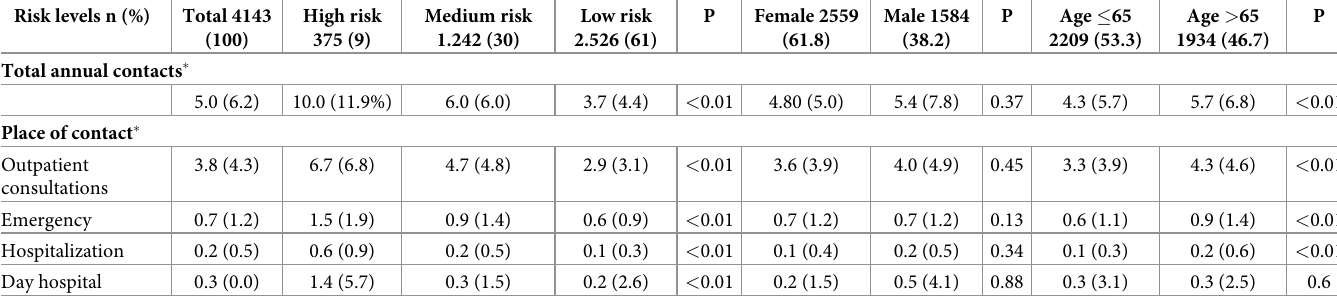
Table 4. Use of hospital care services in the total population of chronic patients and stratified by risk level and sex. Risk levels n